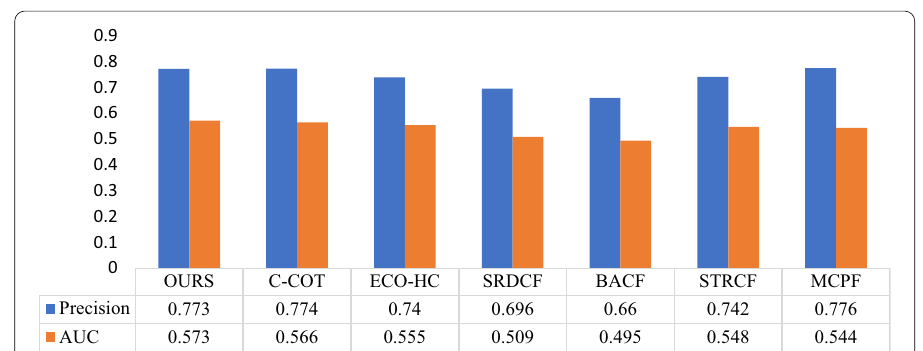
Fig. 9 Comparison of our tracker and other 6 excellent trackers in terms of precision and success rate on TC128